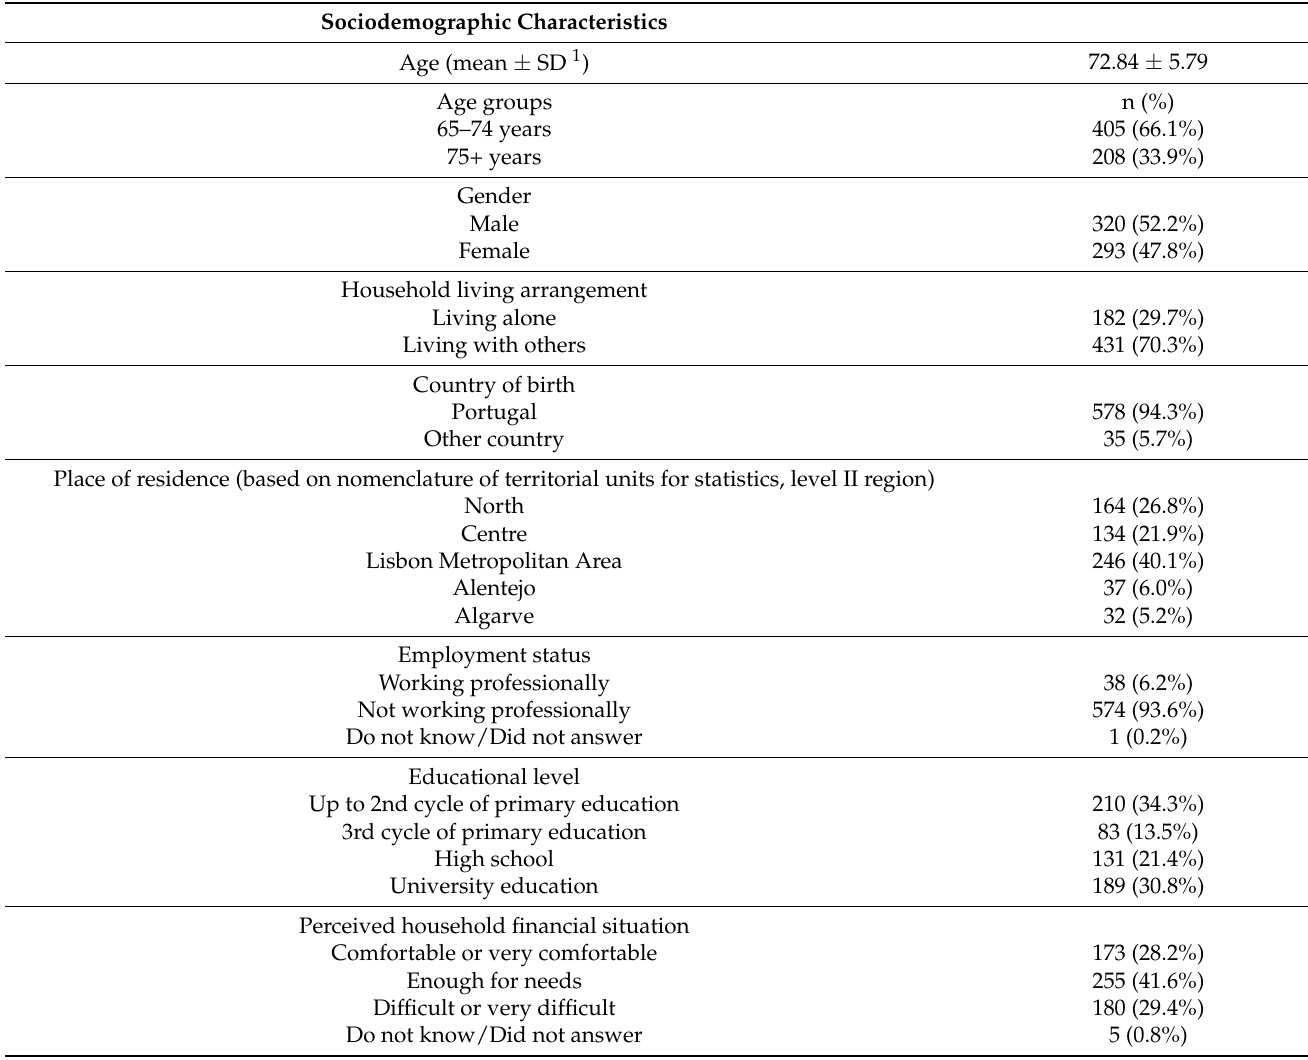
Table 1. Sociodemographic, health and healthcare-related characteristics of the surveyed